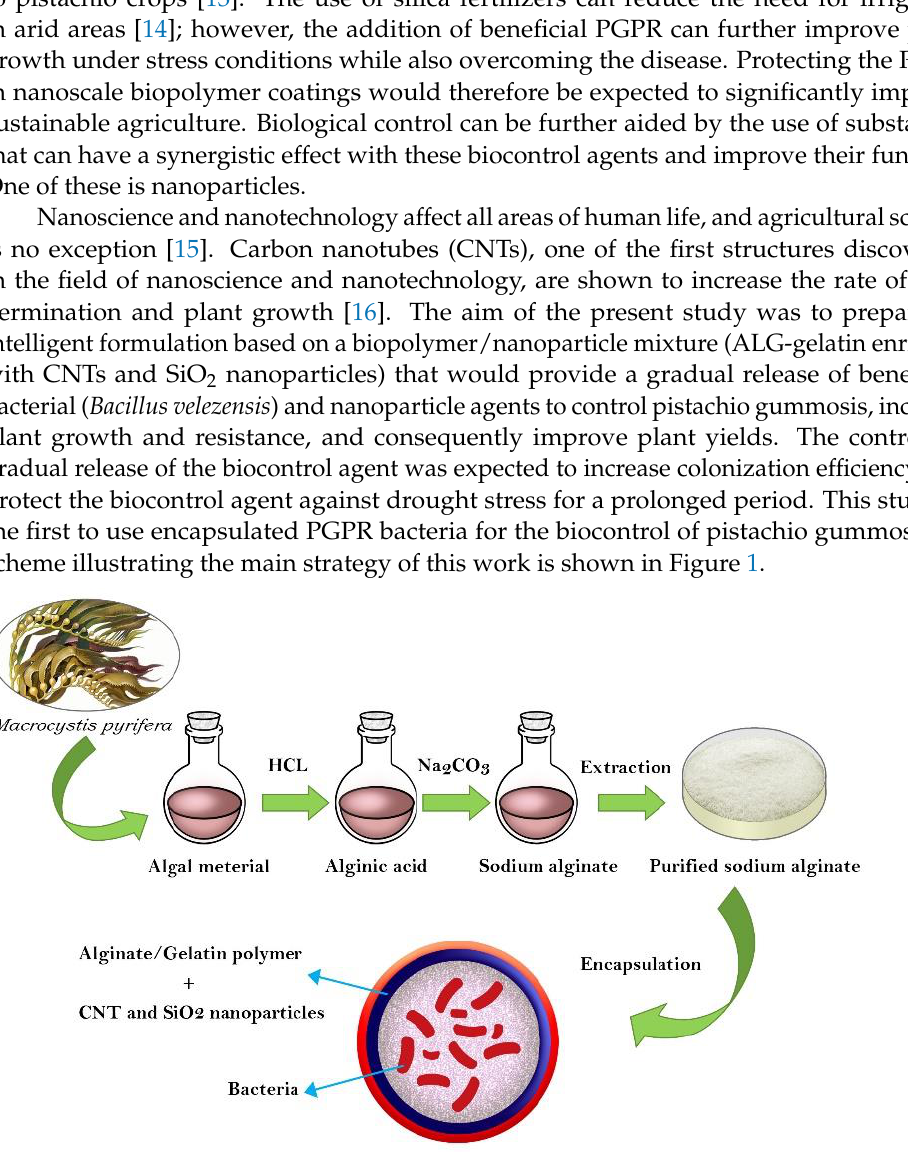
Figure 1. The main strategy used in the study.